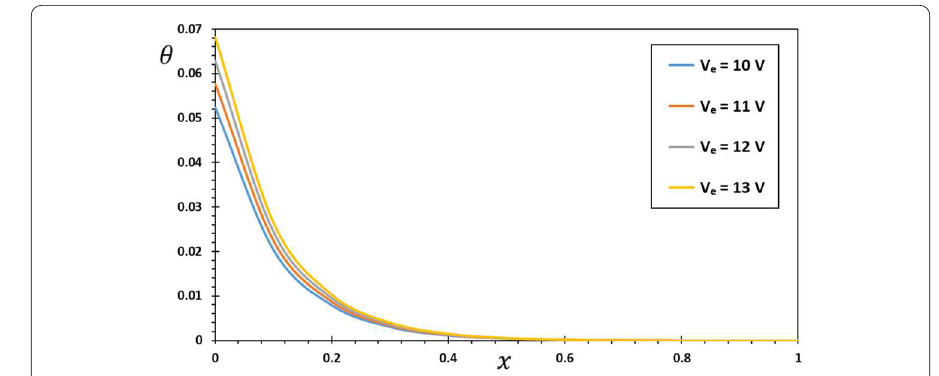
Figure 11 The effect of electric voltage V 2 e on the variation of the temperature θ